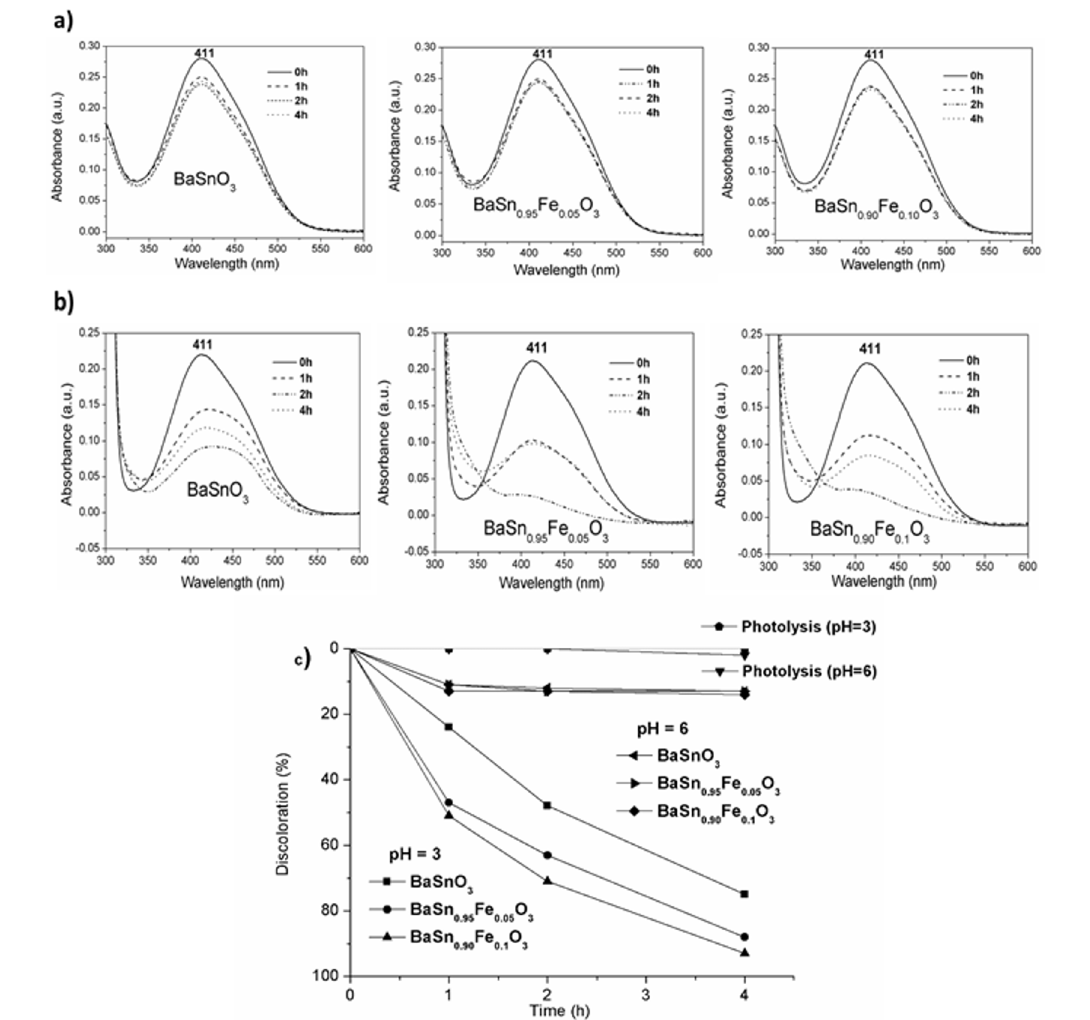
Fe O (x = 0, 0.05 at 0.1 1-x x 3